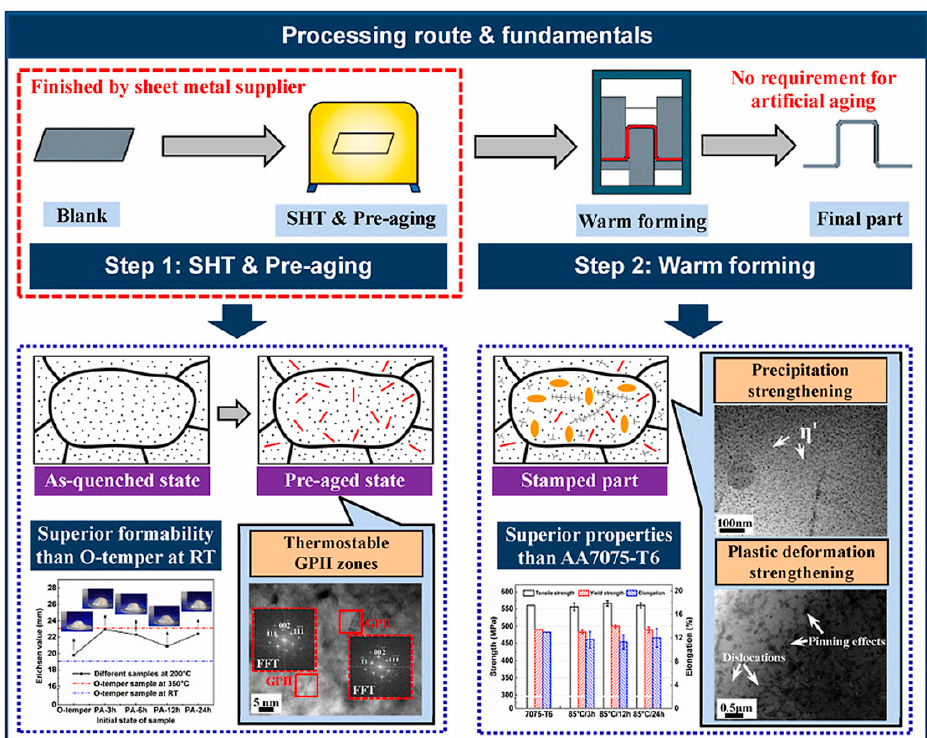
Figure 21. Pre-aged hardening warm forming (PHF) process route and fundamentals [104].